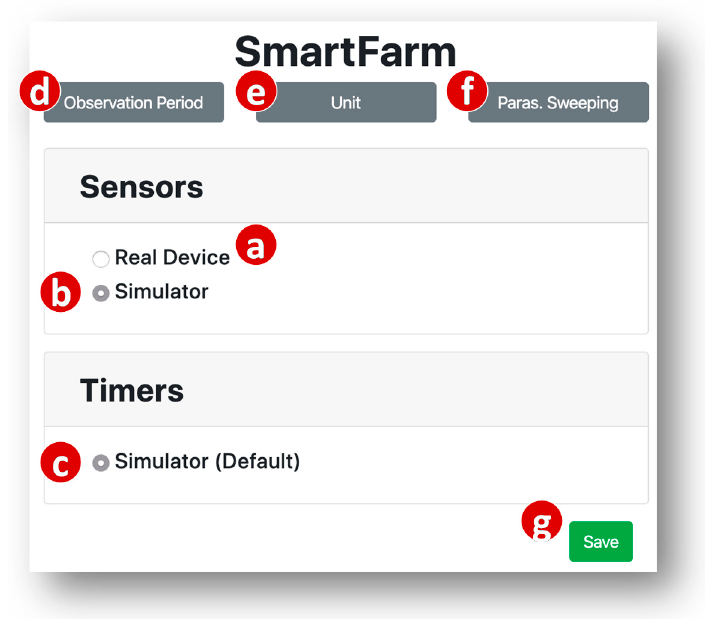
Figure 7. Web-based IoTtalk GUI (cont.).